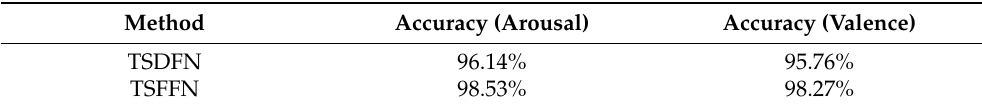
Table 3. The results of different fusion